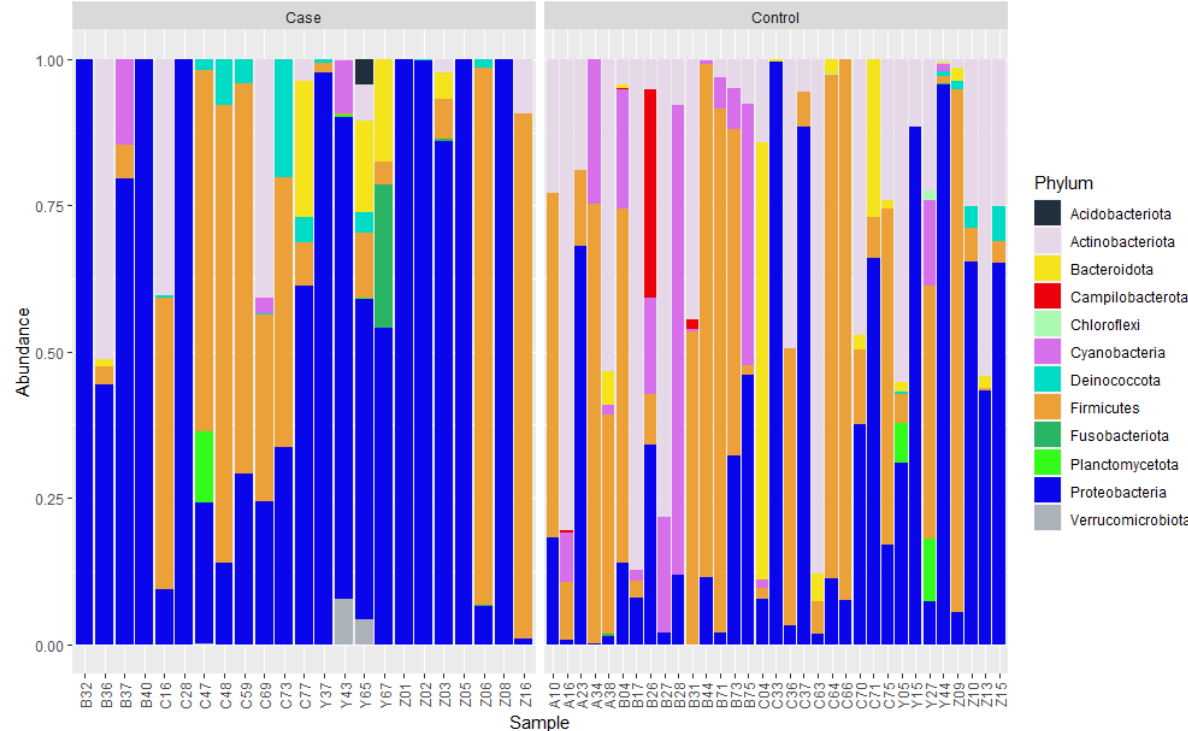
Figure 3. Relative abundance of bacterial phyla ( n = 12) in the hemolymph of moribund mussels (Cases) and apparently normal healthy mussels (Controls) collected in 2017 and 2018 from six sites on the Clinch River, Virginia and Tennessee, USA, as determined by 16SrRNA gene sequence counts.